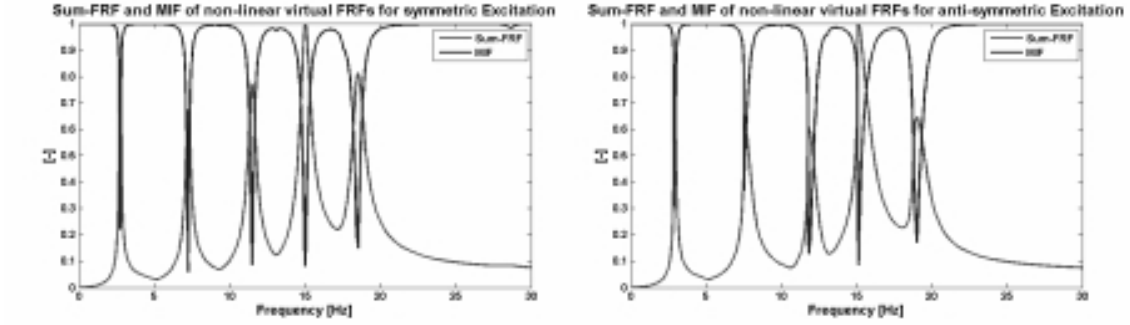
Fig. 3. Summed FRF and MIF for symmetric (left) and anti-symmetric (right) excitation runs.